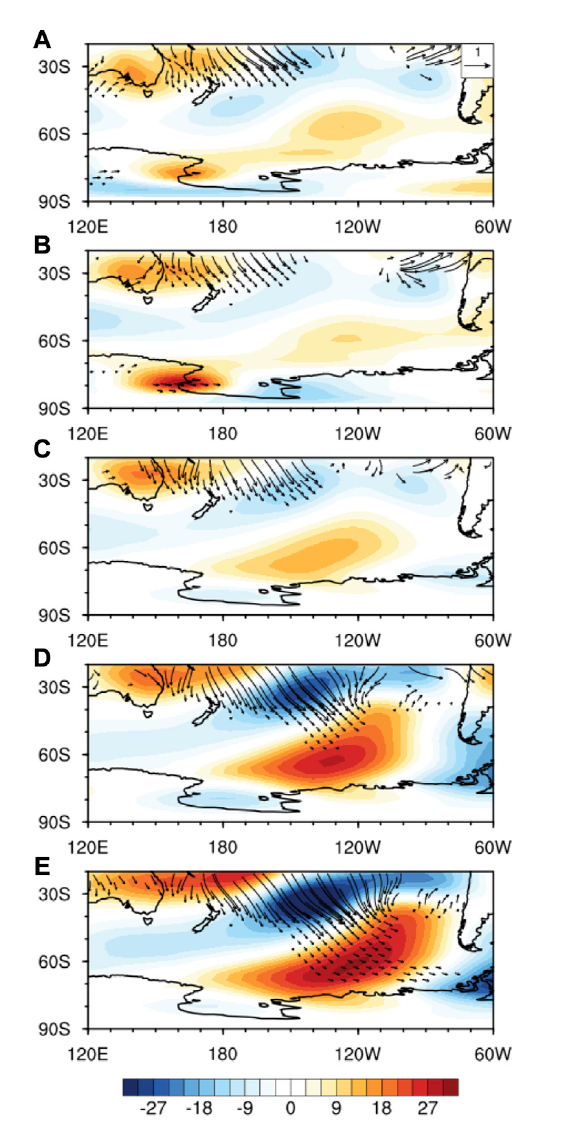
FIGURE 6 Simulated geopotential height anomaly (shaded, m) at 0.5 sigma and corresponding wave activity fl ux (vector, m 2 s – 2 , less than 0.01 m 2 s – 2 is not drawn) at 0.26 sigma in response to the tropical forcing at 160 ° W. Each diabatic heating shown in Figure 5 is initiatedinthemodelwiththebasicstateofthecorrespondingmonth. (A – E) denote from January to May, respectively, and the zonal mean was removed from the geopotential height fi eld to clearly present the wave